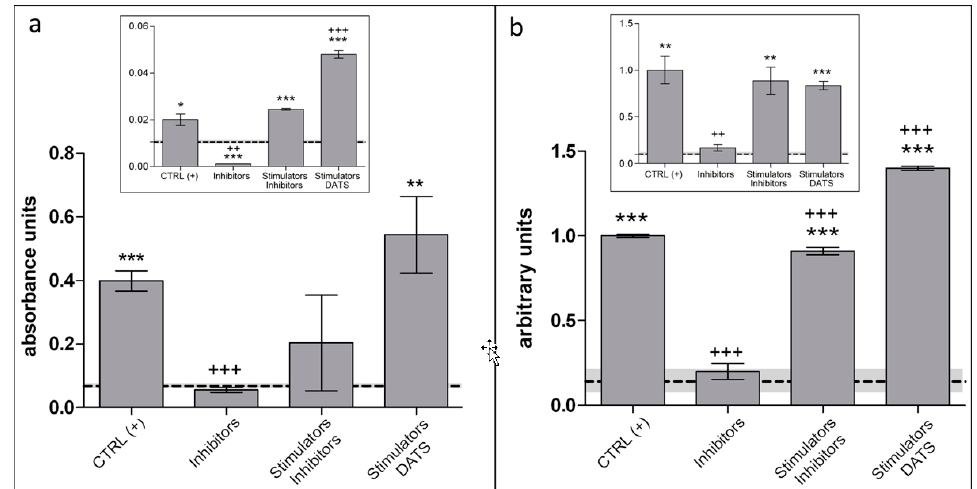
Figure 4. H 2 S release in 6 h and 12 h duration assay by human endothelial cells: ( a ) levels of H 2 S detected by agar trap method in 6 h and in 12 h (inset); and ( b ) levels of H 2 S detected by the LAST method in 6 h and 12 h (inset). CTRL (+)/Stimulators; 5 mM Cys, 5 mM vitamin B6, 10 µ M SAM. Inhibitors; 2 mM DL-PAG and AOAA. (a,b) Samples are compared to the untreated controls CTRL ( − ) (indicated by the dashed baseline, SD is depicted by a gray band; data are illustrated as the mean ± SD; p value versus untreated controls: * p < 0.05, ** p < 0.01, *** p < 0.001, while p value versus CTRL (+): ++ p < 0.01, +++ p < 0.001 (according to Student’s two-tailed t-test).